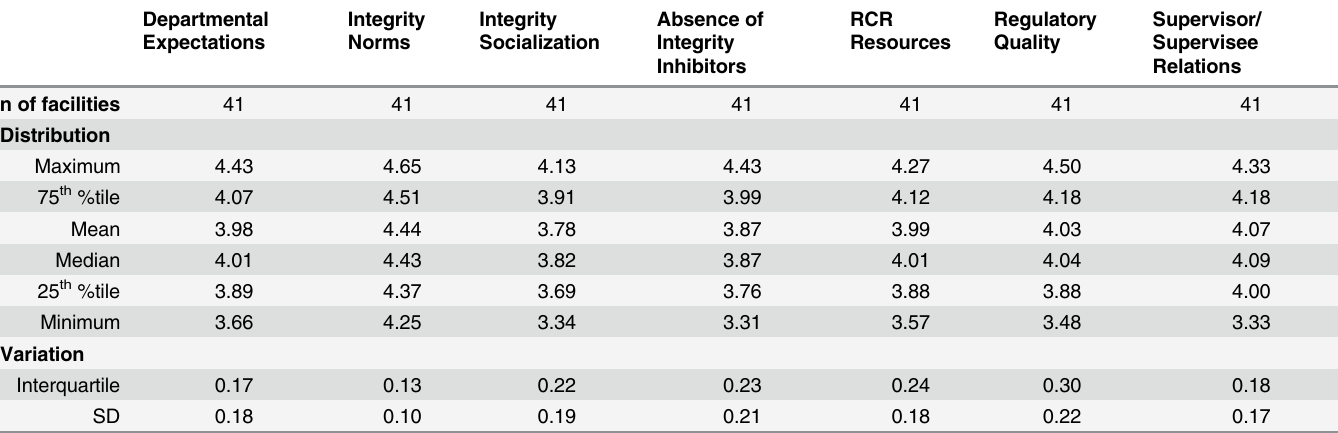
Table 3. Percentile Distributions and Variability of Means Climate Scale Scores by